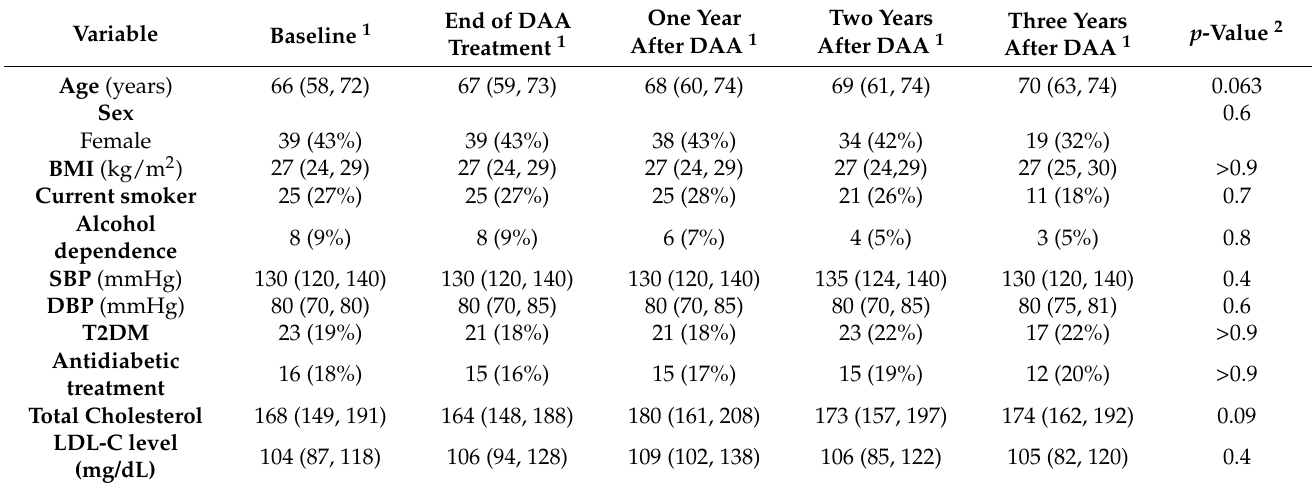
Table 1. Demographics, Cardiometabolic profile and HCV